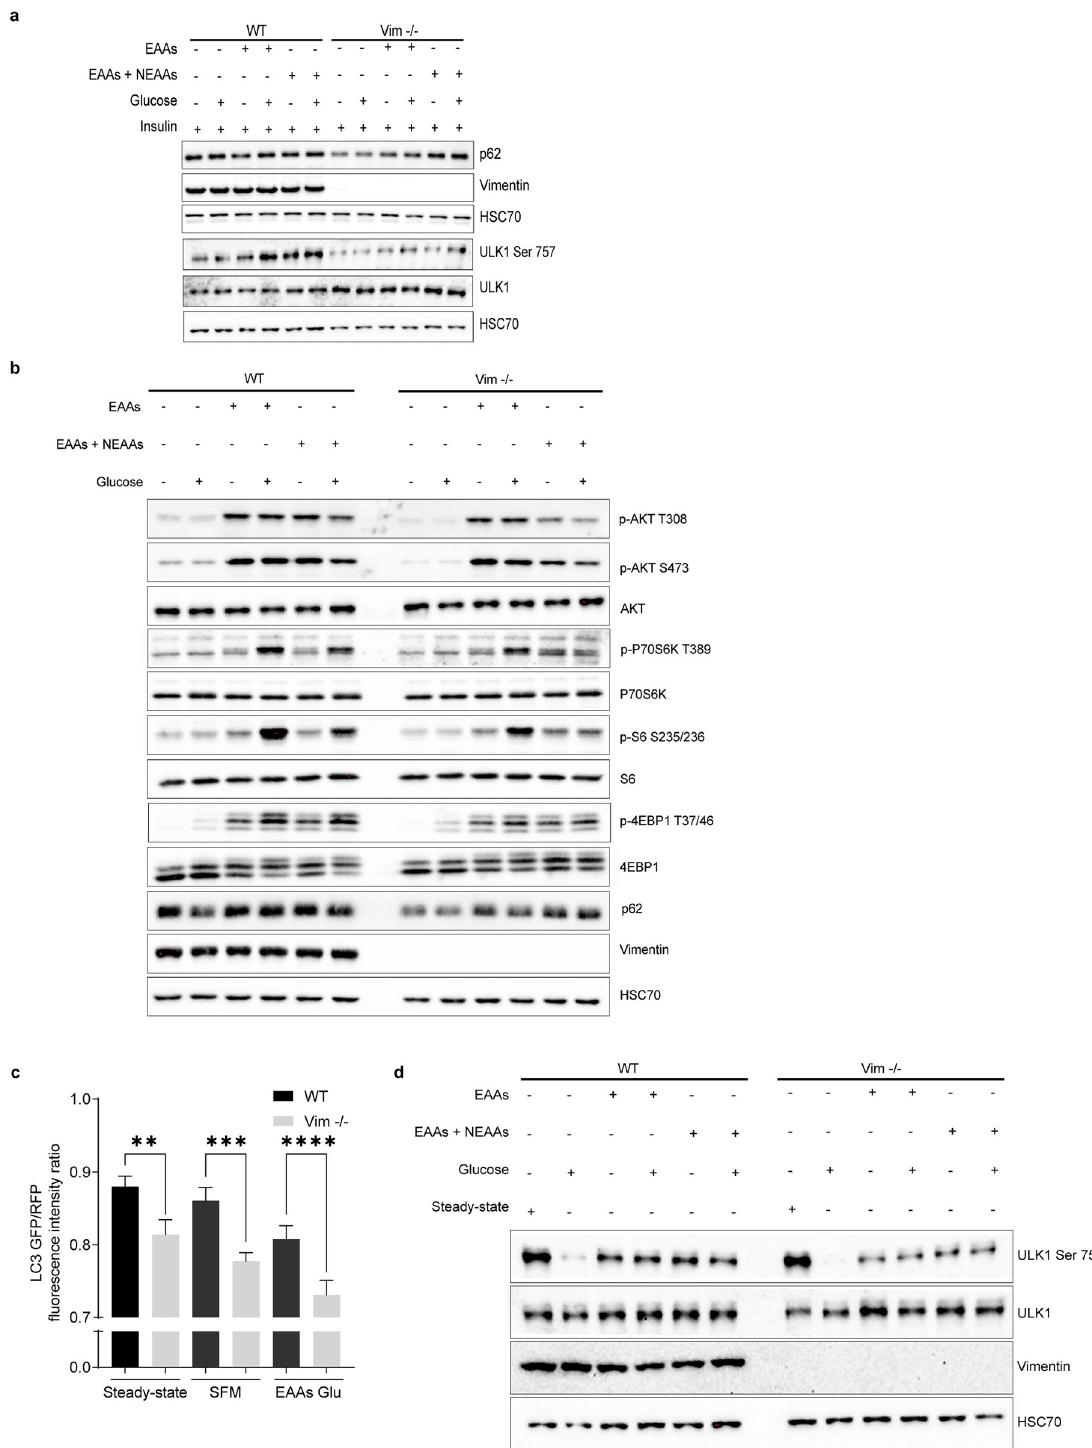
Fig 6. Vimentin protects MEFs from autophagy. ( a ) Western blot analysis of WT and Vim − / − MEFs starved with RPMI media lacking amino acids, glucose, and growth factors for 1 hour, followed by a 30-minute stimulation with 1 mM L-glutamine plus EAAs alone or with NEAAs and 2.5 mM glucose, 100 nM insulin ( n = 3). ( b ) Western blot analysis of WT and Vim − / − MEFs grown 1 hour in RPMI media with different nutrients (1 mM of L-glutamine plus EAAs alone or with NEAAs and 2.5 mM glucose; n = 3). ( c ) Autophagic flux measured through LC3 GFP/RFP fluorescent intensity ratio in cells transfected with 7.5 μ g of pMRX-IP-GFP-LC3-RFP-LC3 Δ G. Graph represents